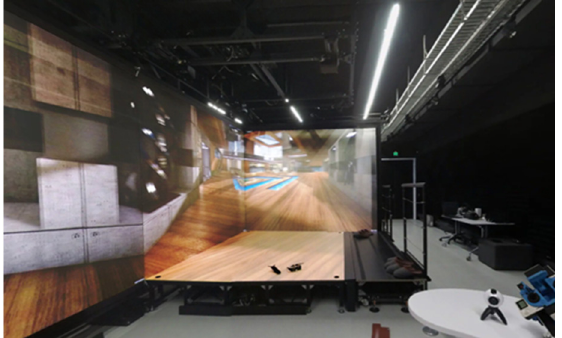
Figure 2. Cad Design Visualization Wall and Immersive and Virtual Reality Cave (Deakin University Cadet Laboratory).